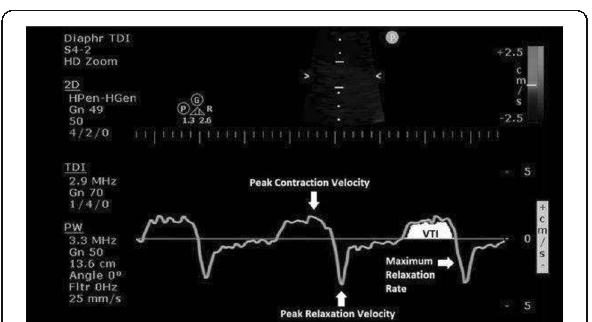
Fig. 2 (abstract 0054). Parameters measured from the TDI